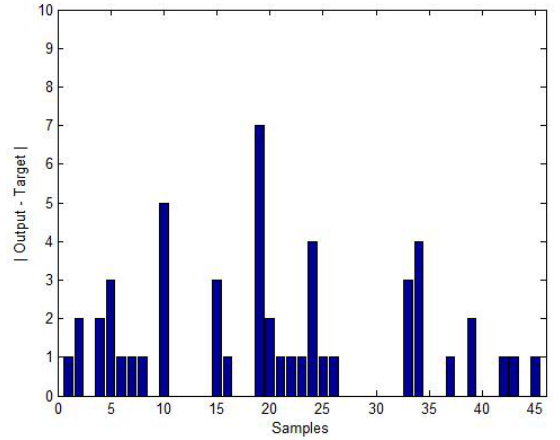
Fig. 5. Comparison between the targets and outputs on the